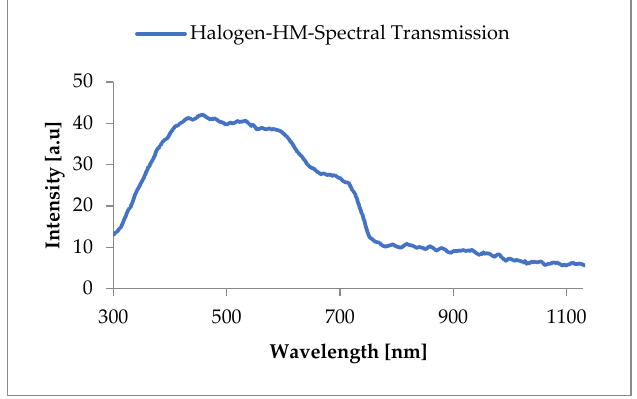
Figure 4. The halogen spectrum transmitted by hot mirror (HM).